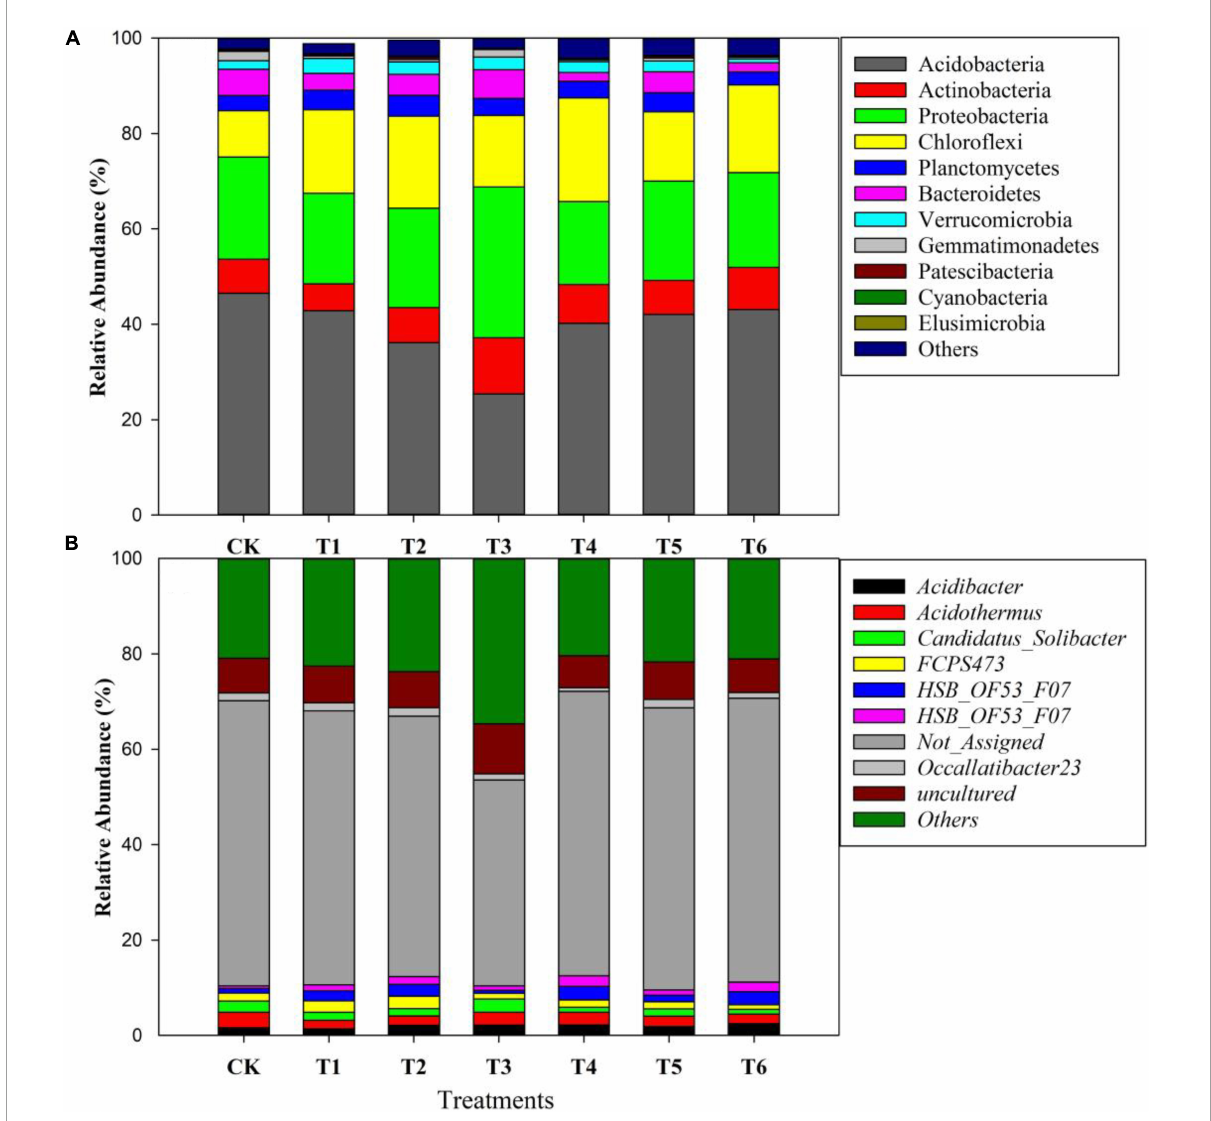
FIGURE5 Changes in the relative abundance of soil bacteria at the phylum level (A) and genus level (B) among different